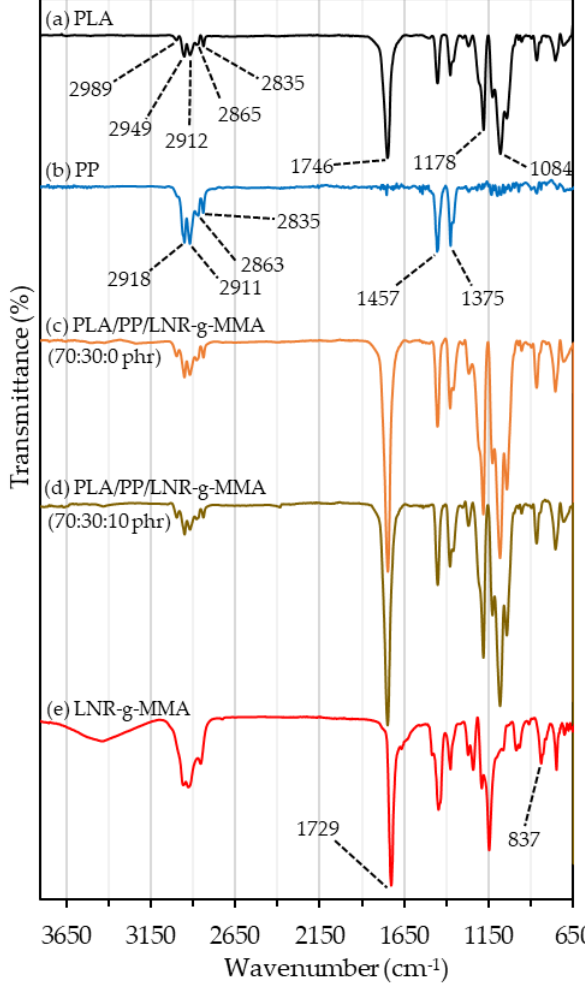
Figure 4. FT−IR spectra of ( a ) PLA, ( b ) PP and PLA/PP (70:30 wt%) blends with LNR−g−MMA of ( c ) 0 phr, ( d ) 10 phr, and ( e )